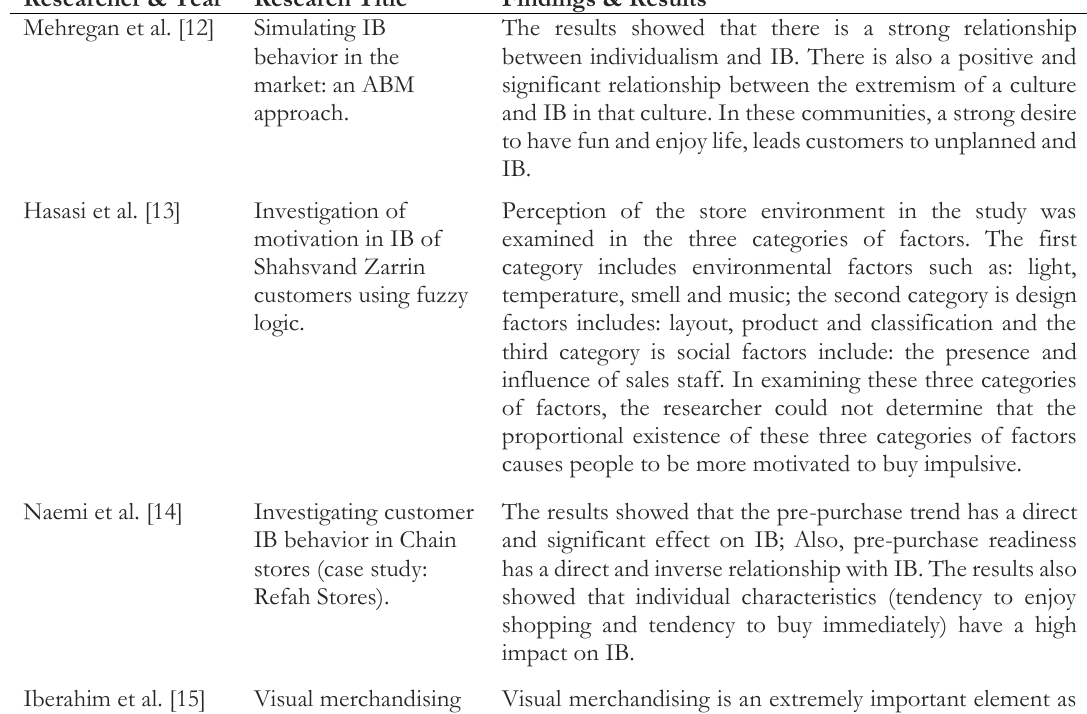
Table 1. Overview of IB history (source: